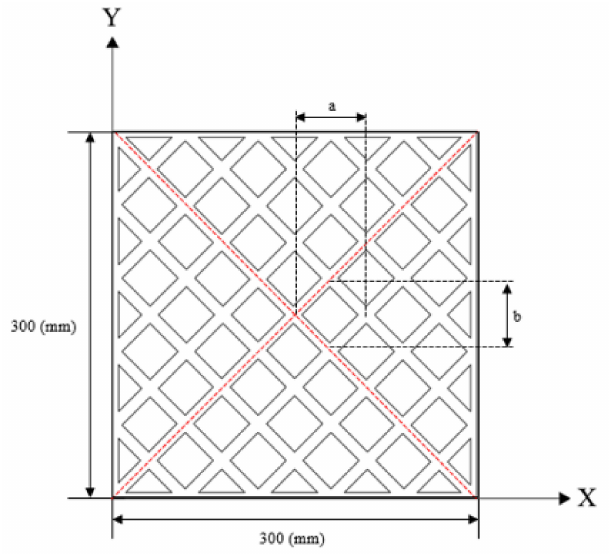
Figure 8. Optimization modeling of the W-type board. a: unit length; b: unit width.